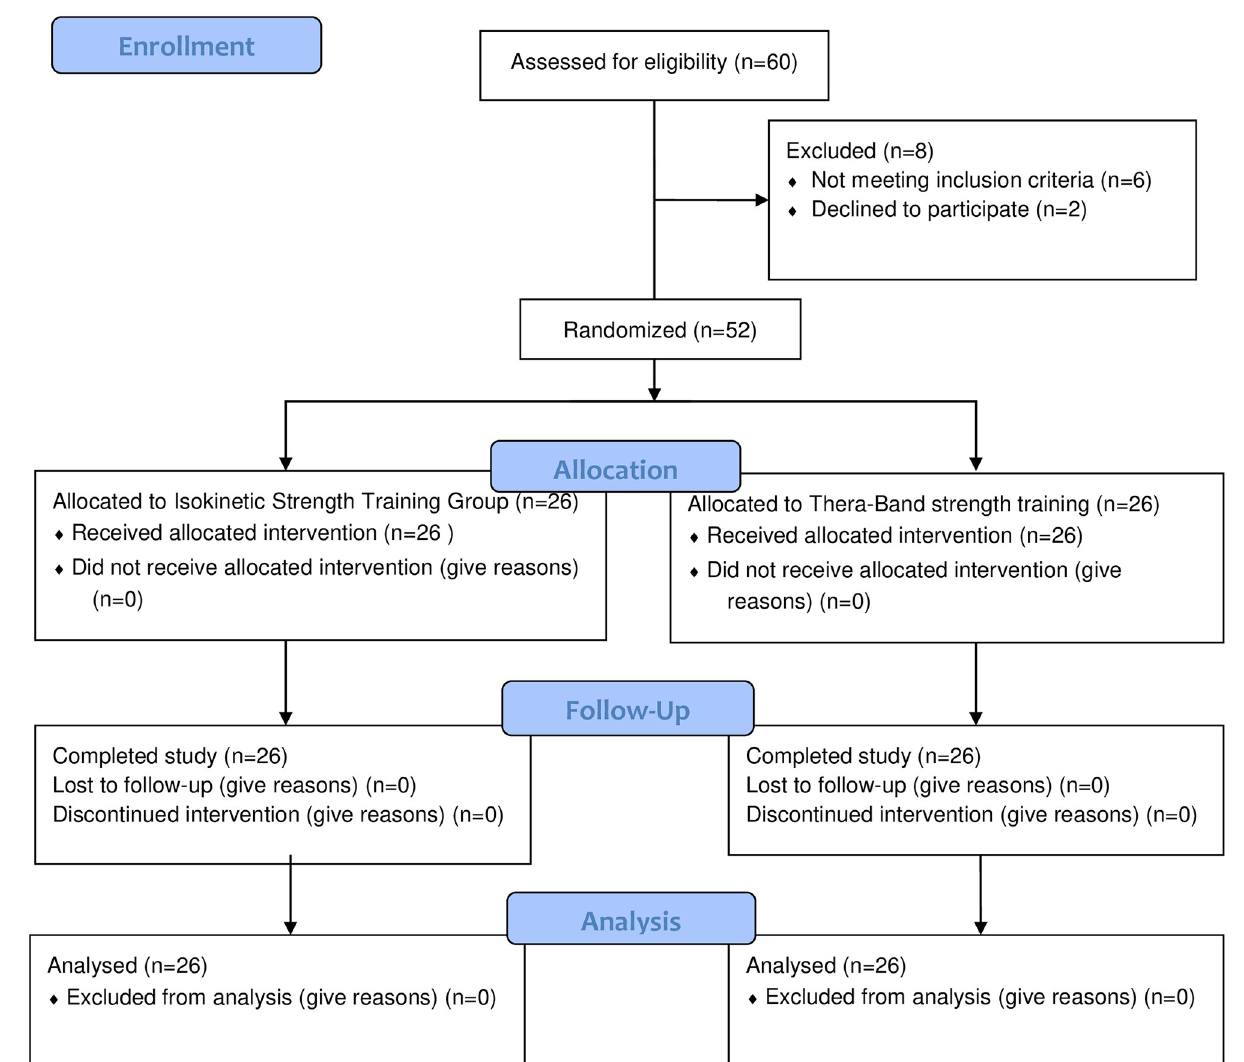
Fig 1. Consolidated standards of reporting trials flow